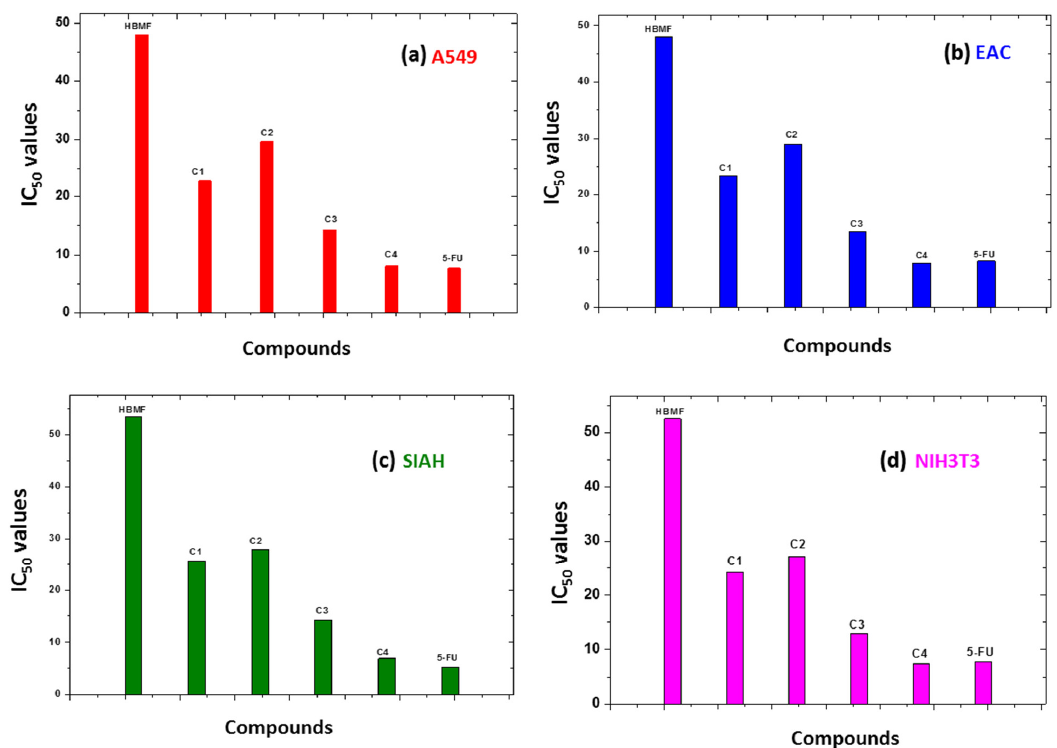
Figure 4. Screening of HMBF and its complexes ( C1 – C4 ) for their cytotoxicity and anti-proliferative potency against ( a ) A549, ( b ) EAC, ( c ) SIAH and ( d ) NIH3T3 depicting their respective IC 50 values. Hematological and Serum Profile Parameters of Cobalt Complex Significant changes were observed in the hematological parameters after the 20 th day of treatment on the EAC cell bearing mice when treated with the complex C4 at maximum dose of 10 mg/kg as compared with the EAC control group. The total WBC count was drastically increased in the EAC control cells, whereas alkaline phosphatase and urea val- ues decreased in EAC bearing groups. The aforesaid parameters either increased, or de- creased, from the normal value when treated with the complex C4 and restored to normal value after the 25th day of the treatment. In comparison with the control EAC carrying mice, an about 48.36% reduction was observed in the number of EAC cells when treated with C4 at a dose of 10 mg/kg (Table 2). At a higher dose of C4 in normal mice, there is a hike in the number of macrophages and peritoneal cell to some extent (Tables S2–S4). Table 2. Showing hematological and serum profiles of the normal mice and normal non-tumor bear- ing mice treated with complex C4 . Hematological and Serum Profile Parameters